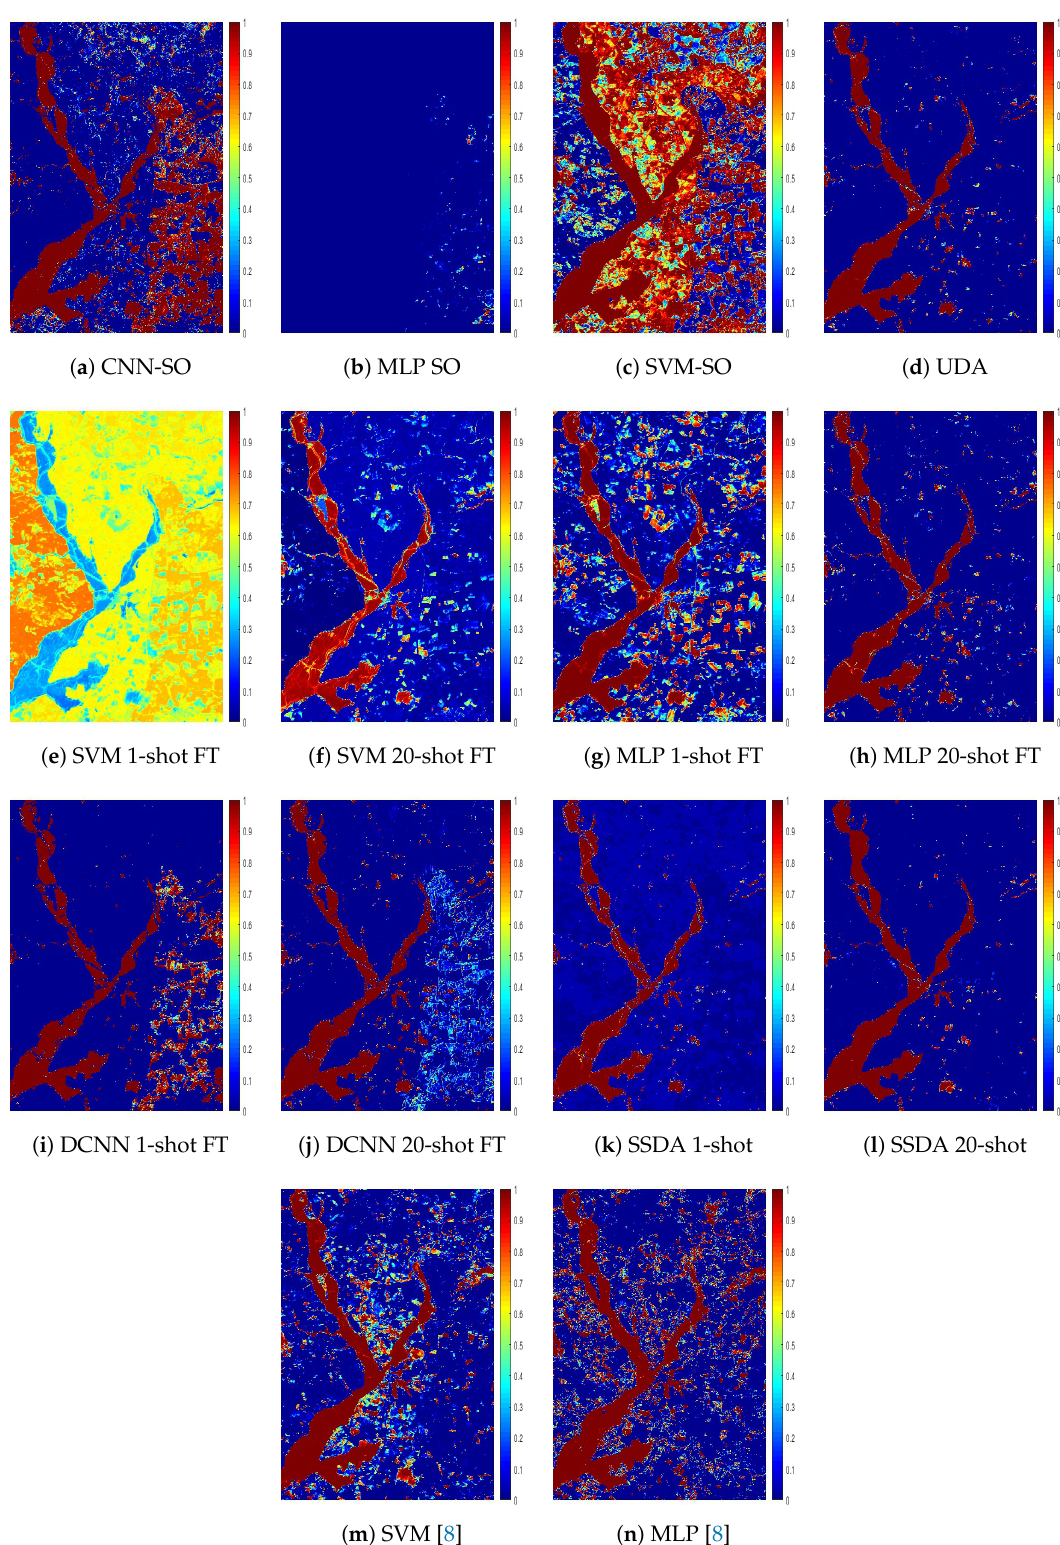
Figure 7. Original predicted probability (OPP) maps. Blue represents the probability ‘0’ and Red represents probability